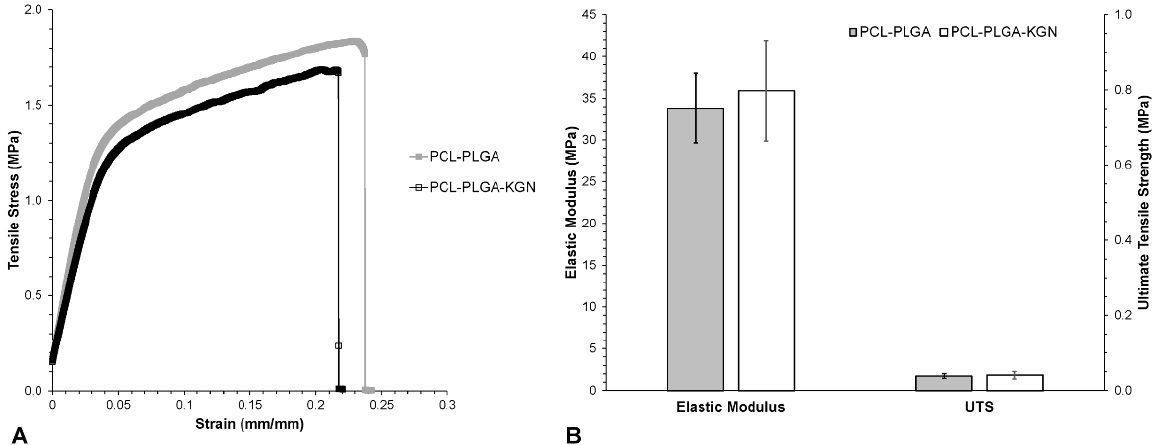
Figure 2. Mechanical properties of electrospun PCL-PLGA with and without KGN: ( A ) representative stress–strain curves and ( B ) material properties. Differences between control and KGN were not statistically significant. Error bars = ± one standard deviation.